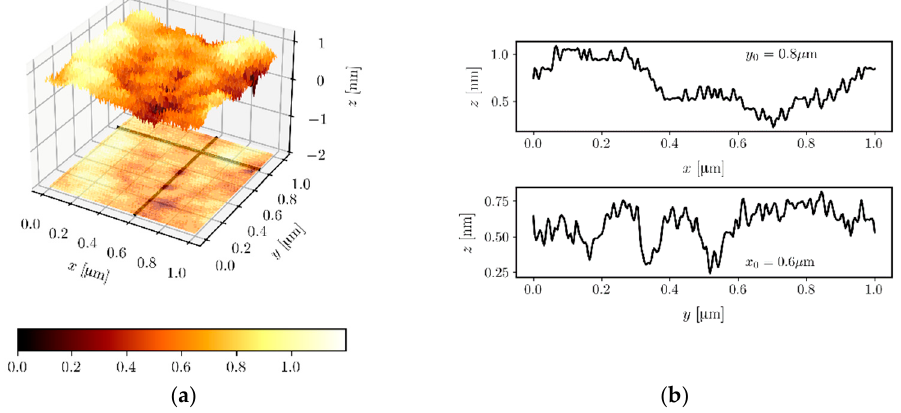
Figure 8. ( a ) AFM topographical image of an SiO x :TiO y thin film deposited on a soda-lime glass substrate, obtained for the area of size 1.0 × 1.0 μ m 2 . ( b ) Surface profiles in two cross-sections.